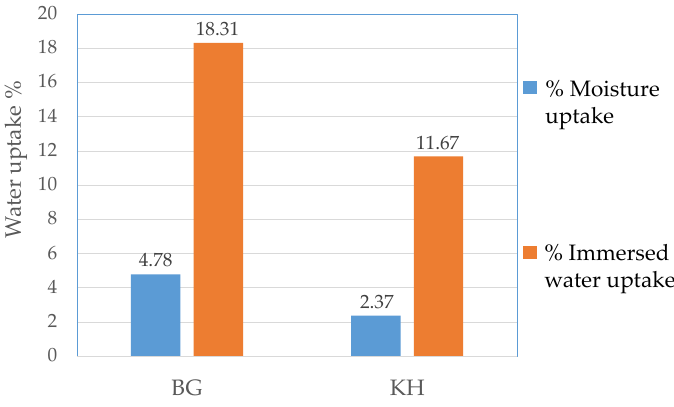
Figure 4. Water uptake results for the samples.